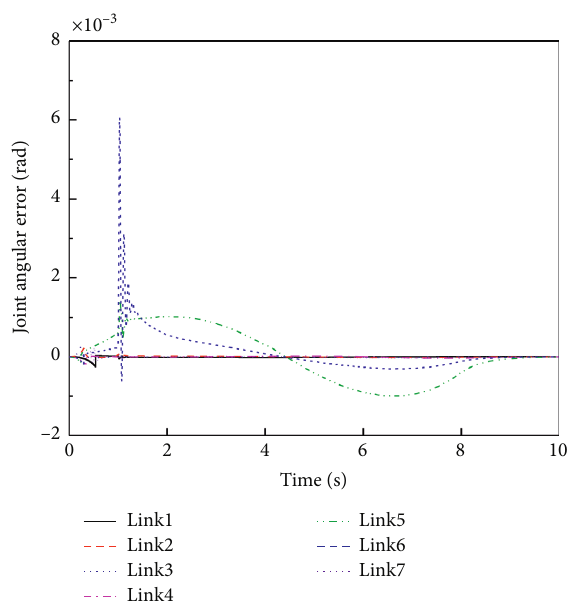
Figure 9: Joint angle tracking error (rad).